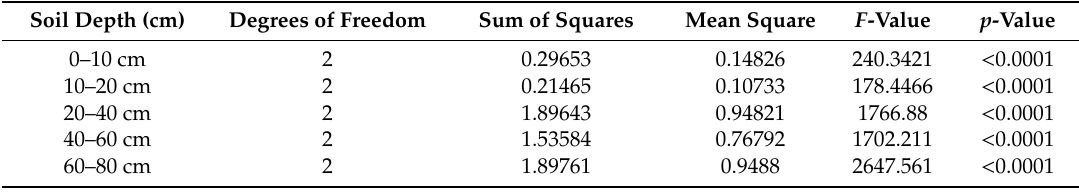
Table 2. Comparison of soil water content at different depths by one-factor analysis of variance.